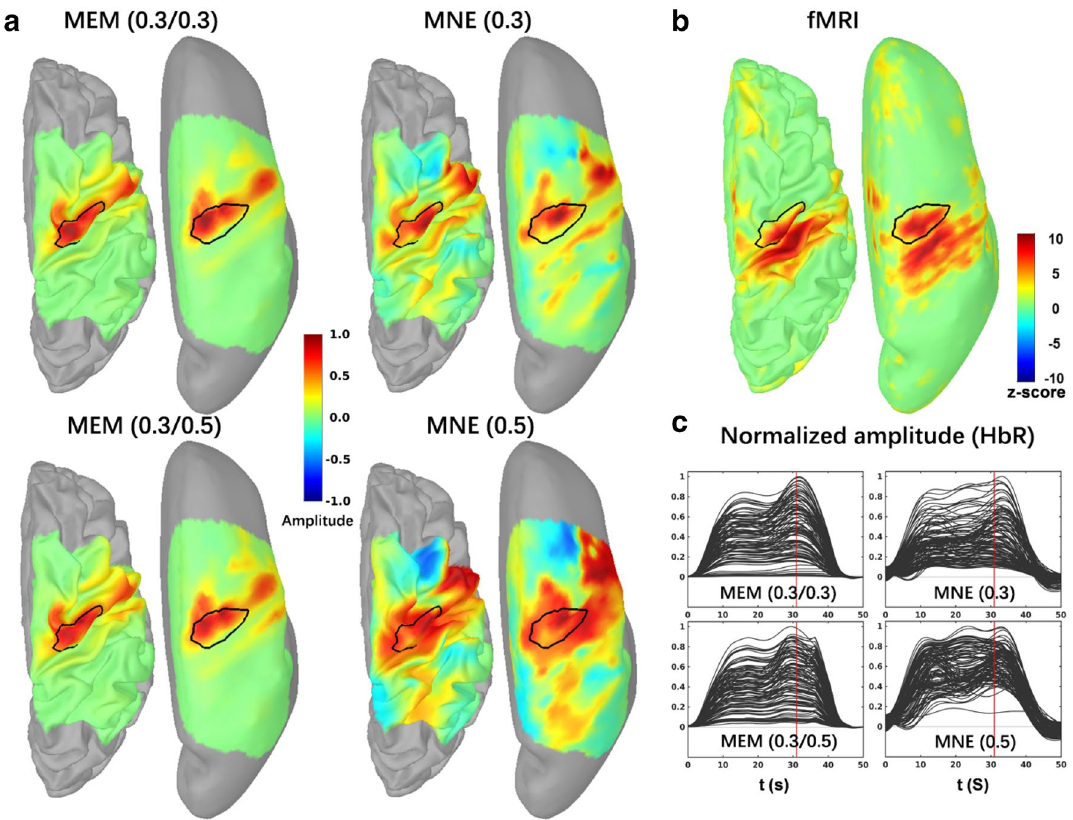
Figure 7. Application of MEM versus MNE reconstruction of HbR during a finger tapping task on one healthy subject. ( a ) Reconstructed maps of HbR (e.g. 20% inflation on the left and 100% inflation on the right side.) from MEM and MNE with different depth compensations. Each map was normalized by its own global maximum. ( b ) fMRI Z-map results projected along the cortical surface. ( c ) Reconstructed time courses of HbR within the hand knob region from MEM and MNE. Note that the hand knob region, represented by the black profile, was also matched well with the mean cluster of fMRI activation map on primary motor cortex. No statistical threshold was applied on fNIRS reconstructions. Figure created by Brainstorm 59 using the NIRSTORM plugin developed by our team (https:// github. com/ Nirst